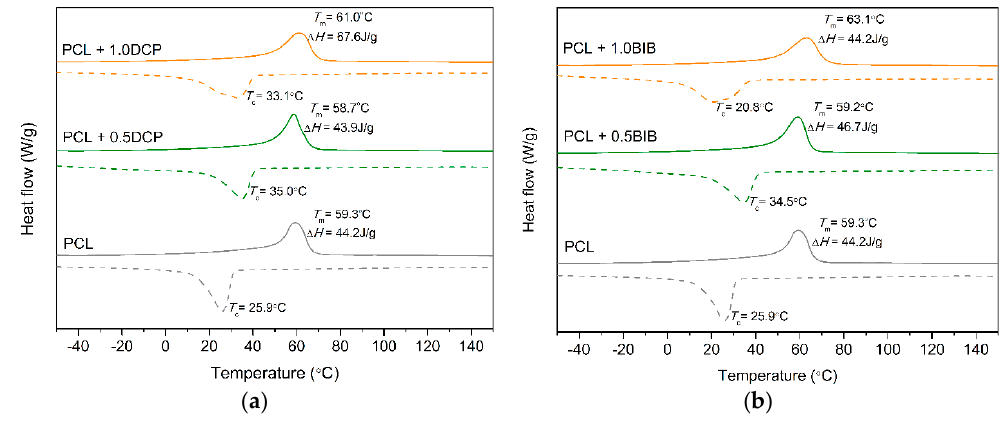
Figure 4. DSC thermograms for PCL modified by DCP ( a ) and PCL modified by BIB ( b ).